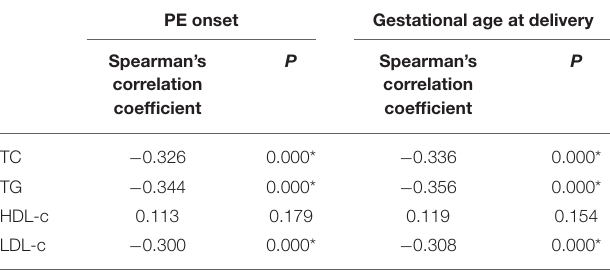
TABLE 3 | Correlation between lipid profile and PE onset or gestational age at